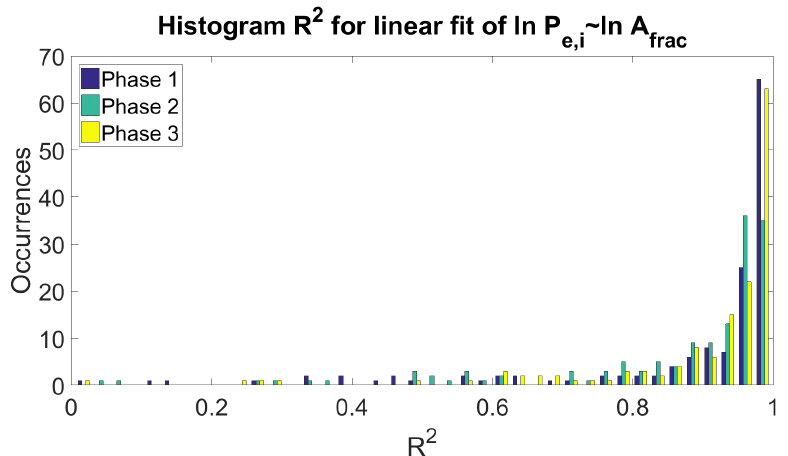
Figure 8. Histogram of the coefficient of determination R 2 for the linear regression of lnP e , i ∼ lnA frac for phases 1, 2 and 3.